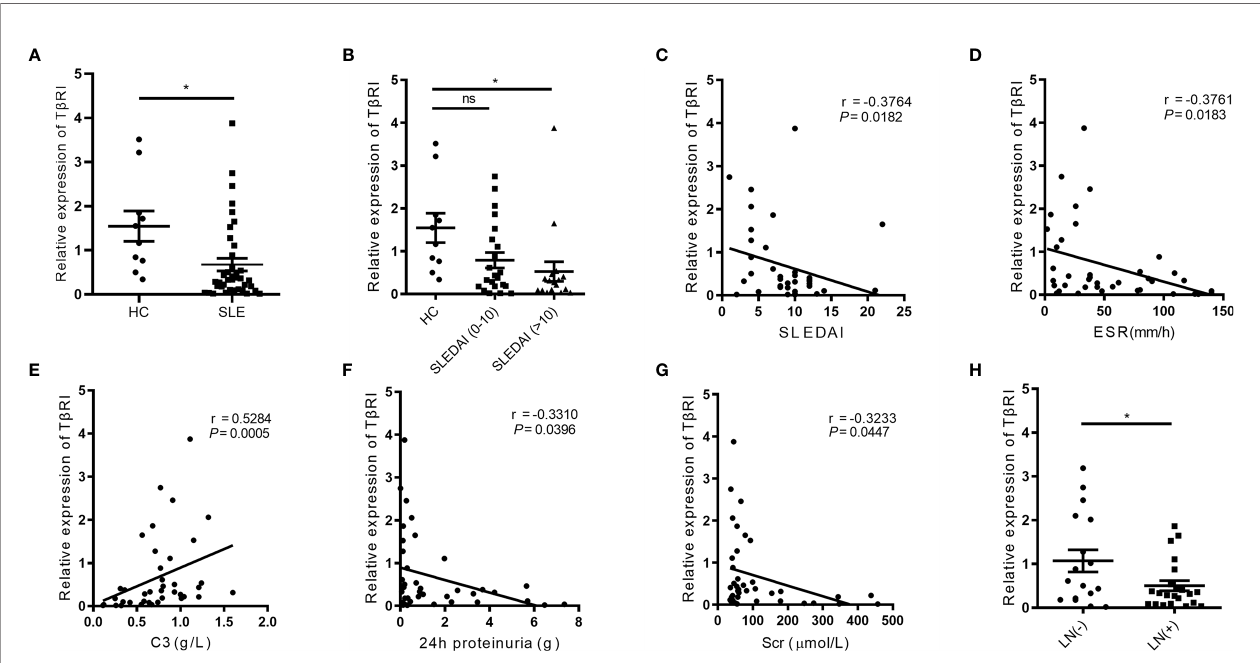
FIGURE 1 | The TGF b RI expression in naïve CD4 + T cells is lower in SLE patients and correlates with disease-related variables. (A) The level of TGF b RI (T b RI) mRNA in naïve CD4 + T cells was compared among SLE patients (n = 39) and healthy controls (HC) (n = 10). (B) The relative TGF b RI mRNA level of two lupus subgroups was determined, which included moderate to severe disease activity subgroup (SLE disease activity index, SLEDAI>10) (n = 17) and stable and mild disease activity subgroup (SLEDAI 0-10) (n = 22). (C – E) The correlations between TGF b RI mRNA level and SLEDAI, erythrocyte sedimentation rate (ESR), and C3. (F, G) The association between TGF b RI mRNA level and 24-h proteinuria and serum creatinine (Scr). (H) Lower level of TGF b RI mRNA was found in patients with lupus nephritis (LN) (n = 22) than patients without LN (n = 17). Error bars indicate SEM. * P < 0.05. ns, no signi fi cant